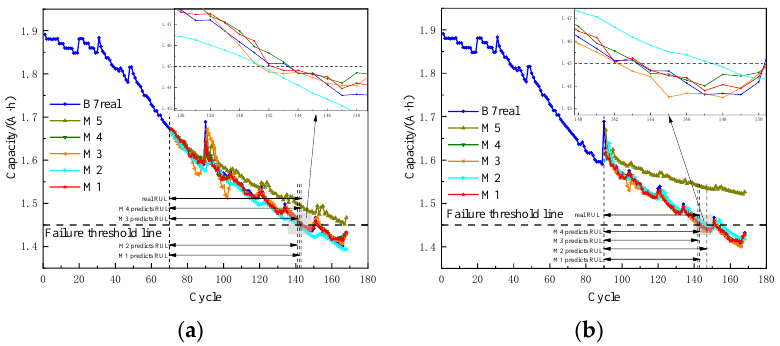
Figure 14. Prediction results of the B7 battery. ( a ) Prediction starting point: 70. ( b ) Prediction starting point: 90.